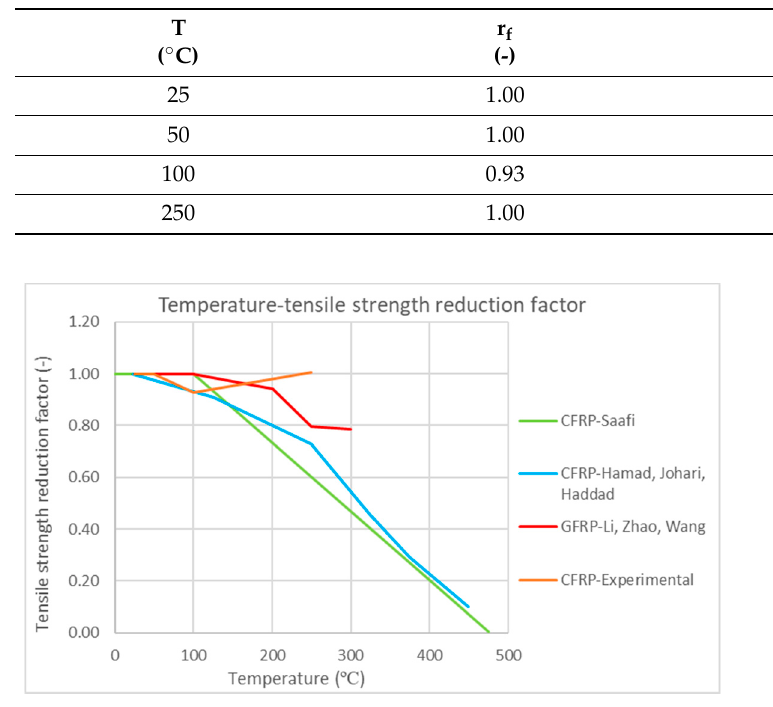
Figure 22. Temperature–tensile strength reduction factor curves [18,23,30].